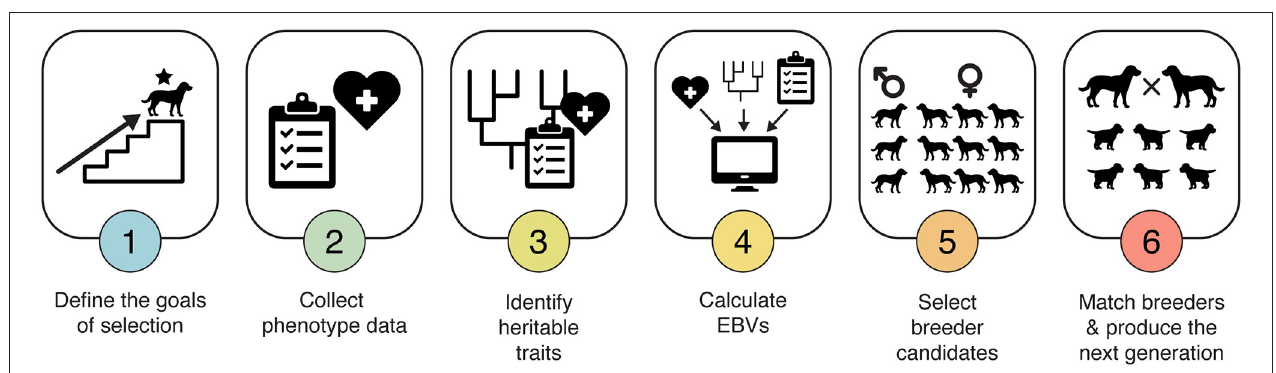
FIGURE 2 | Six-step approach to EBV selection. Implementing an EBV-based selection program can be daunting. By distilling it down to just six steps, each supported by tools and training available through IWDR, this method of making breeding decisions can be made accessible to both working dog breeders and hobby